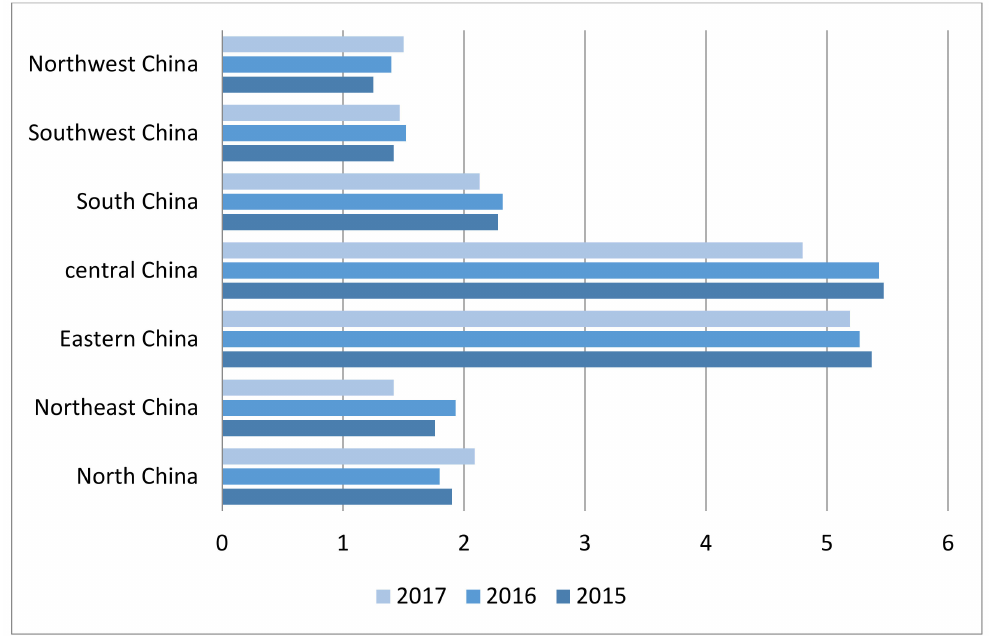
Figure 3. Antibiotic consumption in DID in different regions of China from 2015 and